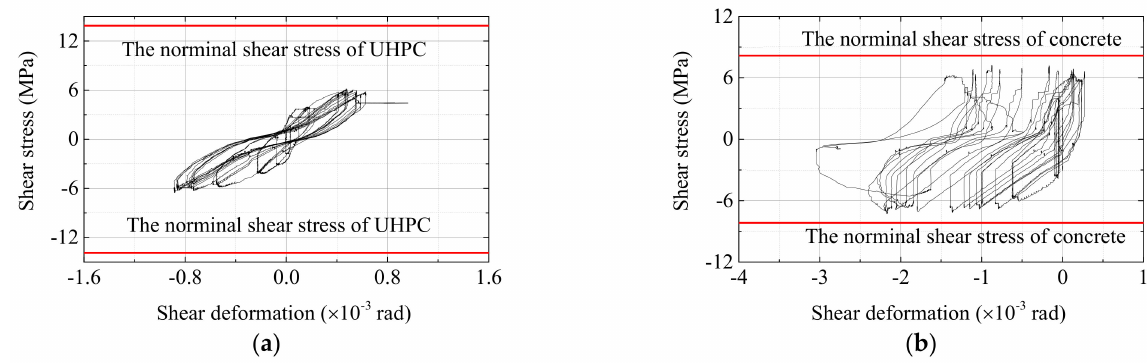
Figure 14. Shear stress versus shear distortion. ( a ) Specimen PI1 and ( b ) Specimen RI1.